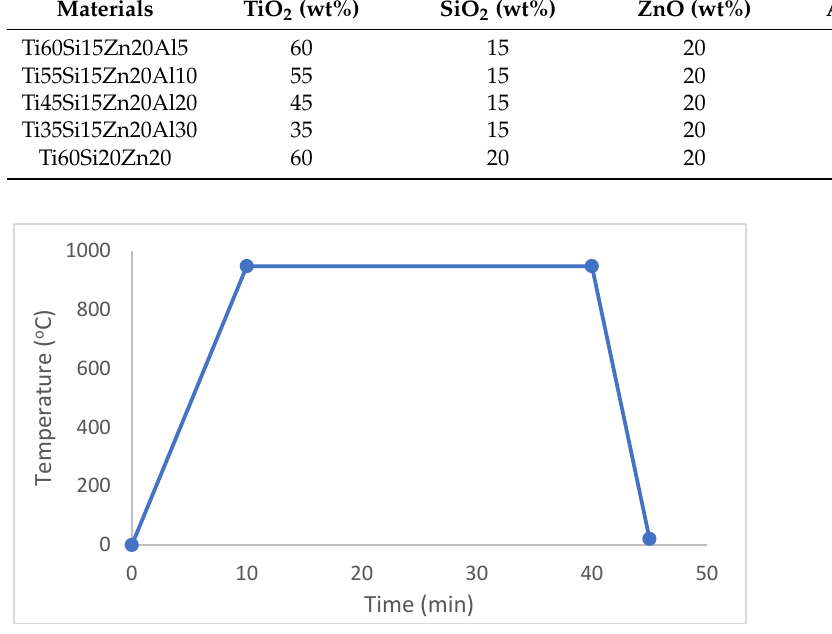
Figure 1. Hot pressing production phases.